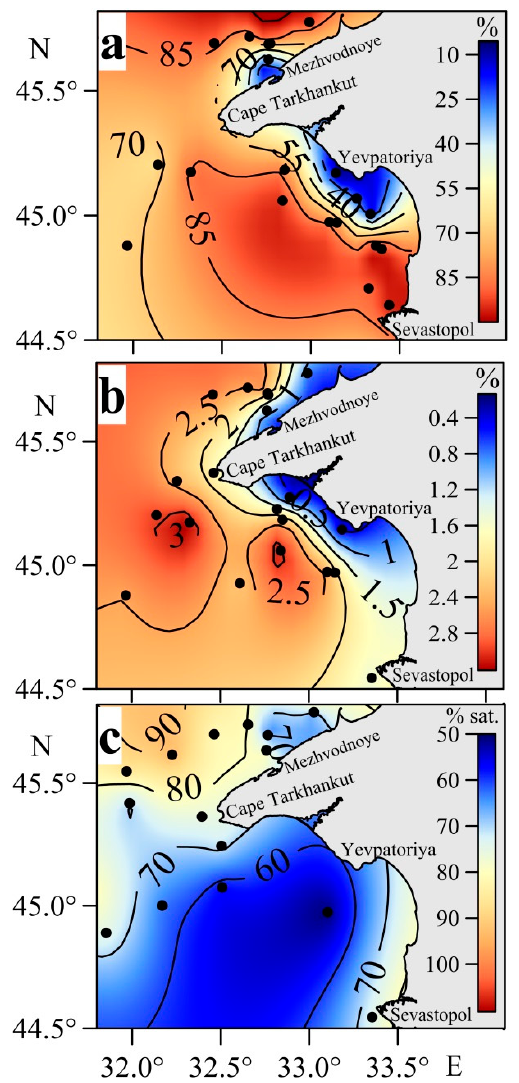
Figure 2. Spatial distribution of the clay fraction ( a ) and C org ( b ) in the sediment surface layer, and ( c ) oxygen saturation in the bottom waters of the northwestern region.